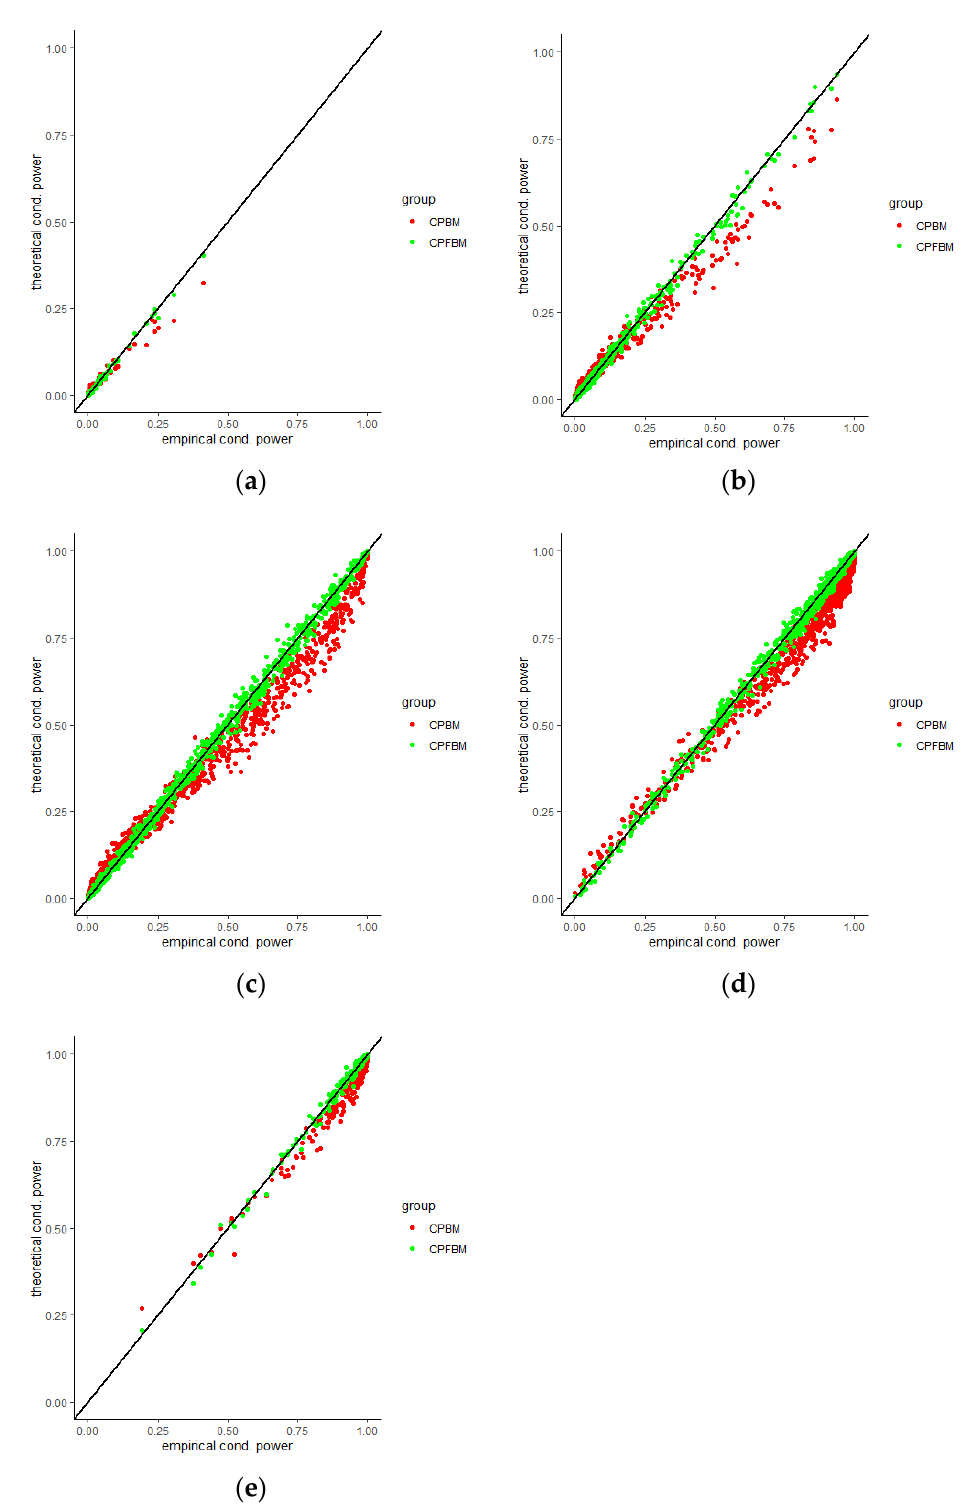
Figure 5. Scatter plots for conditional power under misspecification scenarios (BR design) two con- tinuous covariates with different drift parameters 𝜃 : ( a ) 𝜃 = 0; ( b ) 𝜃 = 0.5; ( c ) 𝜃 = 1; ( d ) 𝜃 = 1.5; ( e ) 𝜃 = 2.